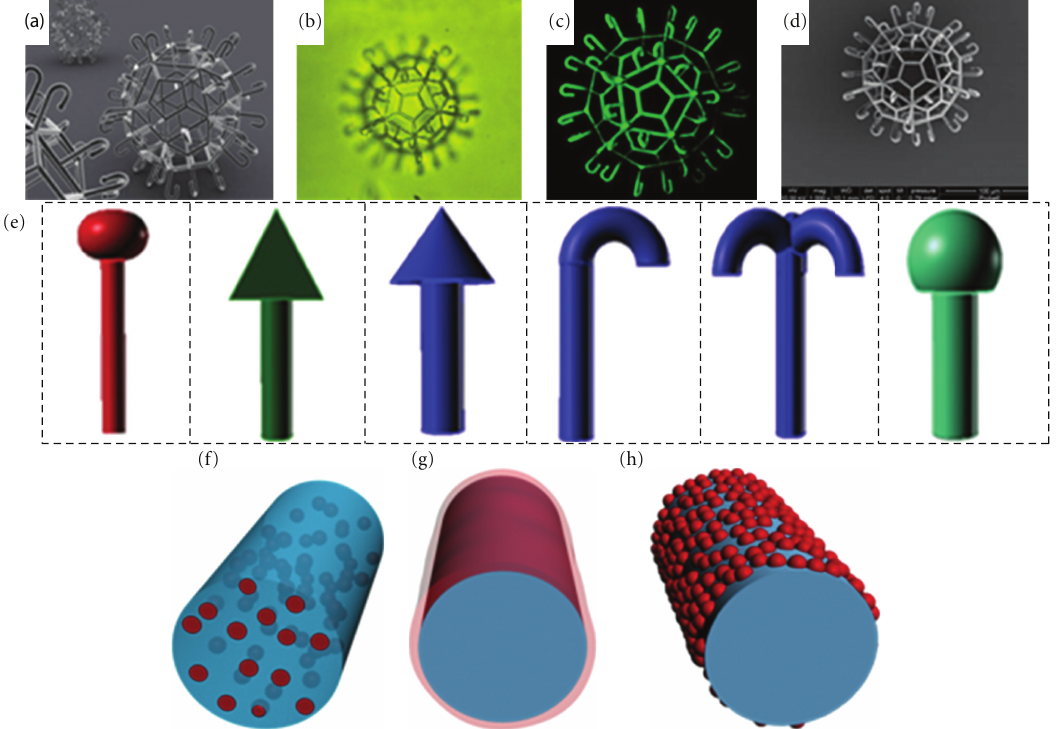
Figure 7: “Lockyballs” or interlockable microsca ff olds for encaging living tissue spheroids. (a) Computer-aided design of lockyball; (b) Light microscopy of lockyball; (c) Confocal microscopy of lockyball; (d) Scanning electron microscopy of lockyball; (e) Di ff erent design variants of lockyball “hooks” which can be used as interlocking mechanism; (f) Section of lockyballs demonstrating magnetic nanoparticles inside; (g) Lockyball with magnetic nanosurface; (h) Section of lockyball demonstrating functionalization with nanoparticles on external